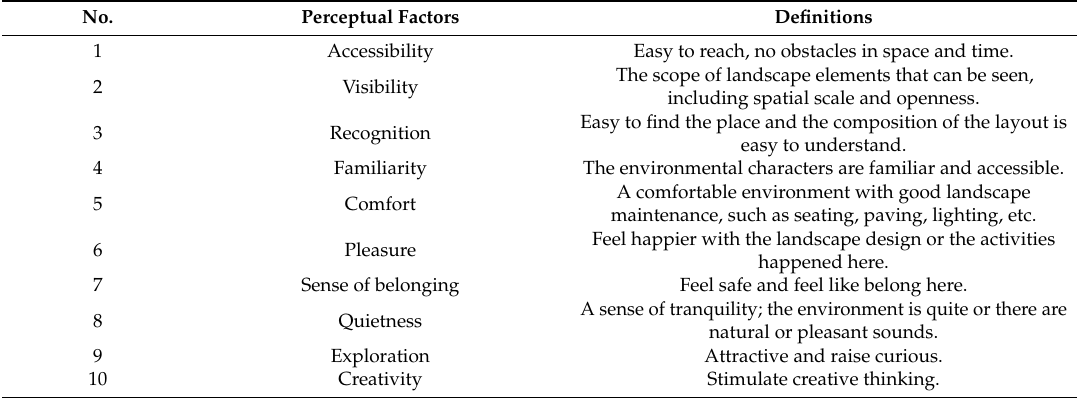
Table 2. Perceptual factors of attention restoration space on the university